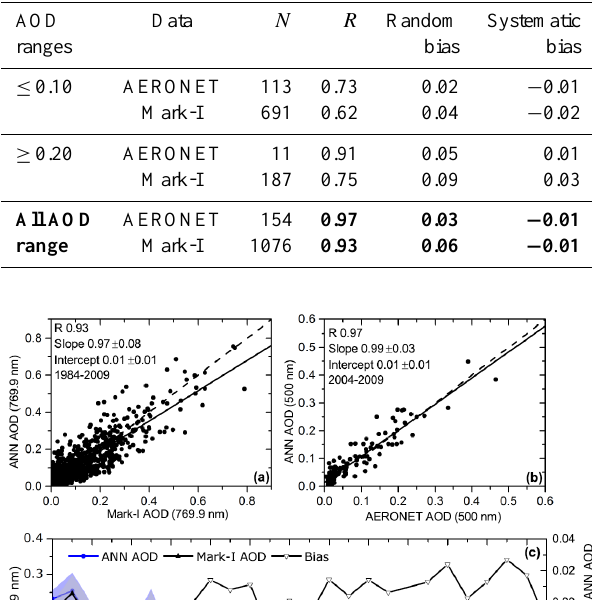
Table 3. Statistics for the difference between AOD observations and ANN AOD estimates for different AOD ranges. The series of dif- ferences between Mark-I AOD and ANN AOD is at 769.9nm in the period 1984–2009 and between AERONET AOD and ANN AOD at 500nm in the period 2004–2009. N is the number of data and R is Pearson correlation coefficient. The bold values represent the R , random bias and systematic bias considering all AOD range for AERONET and Mark-I, respectively.